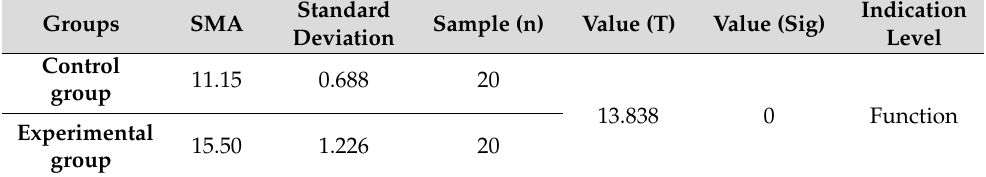
Table 3. Significance of differences between mean scores of experimental group and control group in post-application of cognitive test of practical